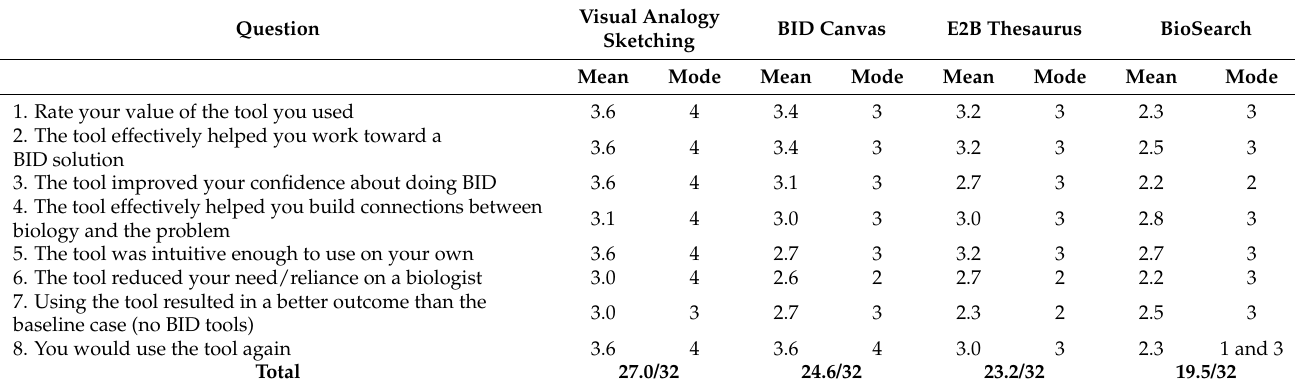
Table 3. Quantitative results of BID tool feedback